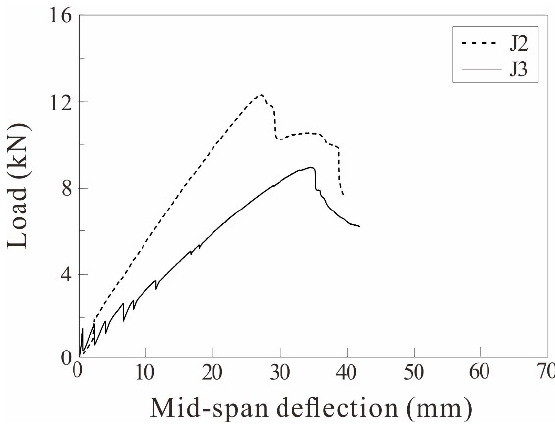
Figure 10. Relationship between the load and mid-span deflection for specimens considering grid longitudinal spacing. longitudinal